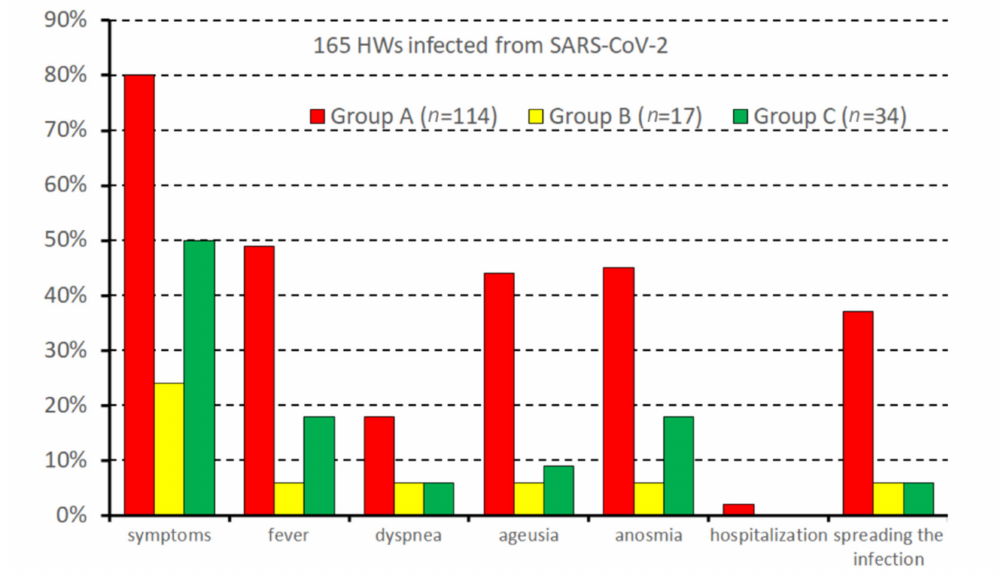
Figure 2. COVID-19-related symptoms, hospitalization, and infection spreading as a function of vaccination